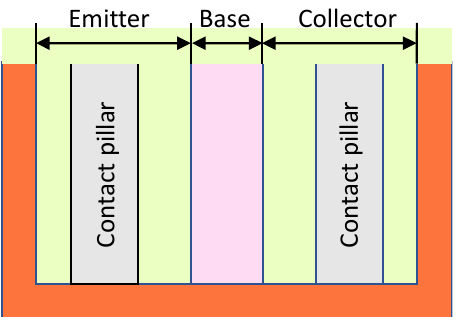
Figure 6. Cross-section along the diagonal of the elementary cell with the bipolar junction transistor in VESTIC technology (green—polycrystalline emitter and collector, pink—base region, orange— insulating silicon dioxide, grey—the contact metal pillars). After deposition of polysilicon, the emitter and collector are shorted.